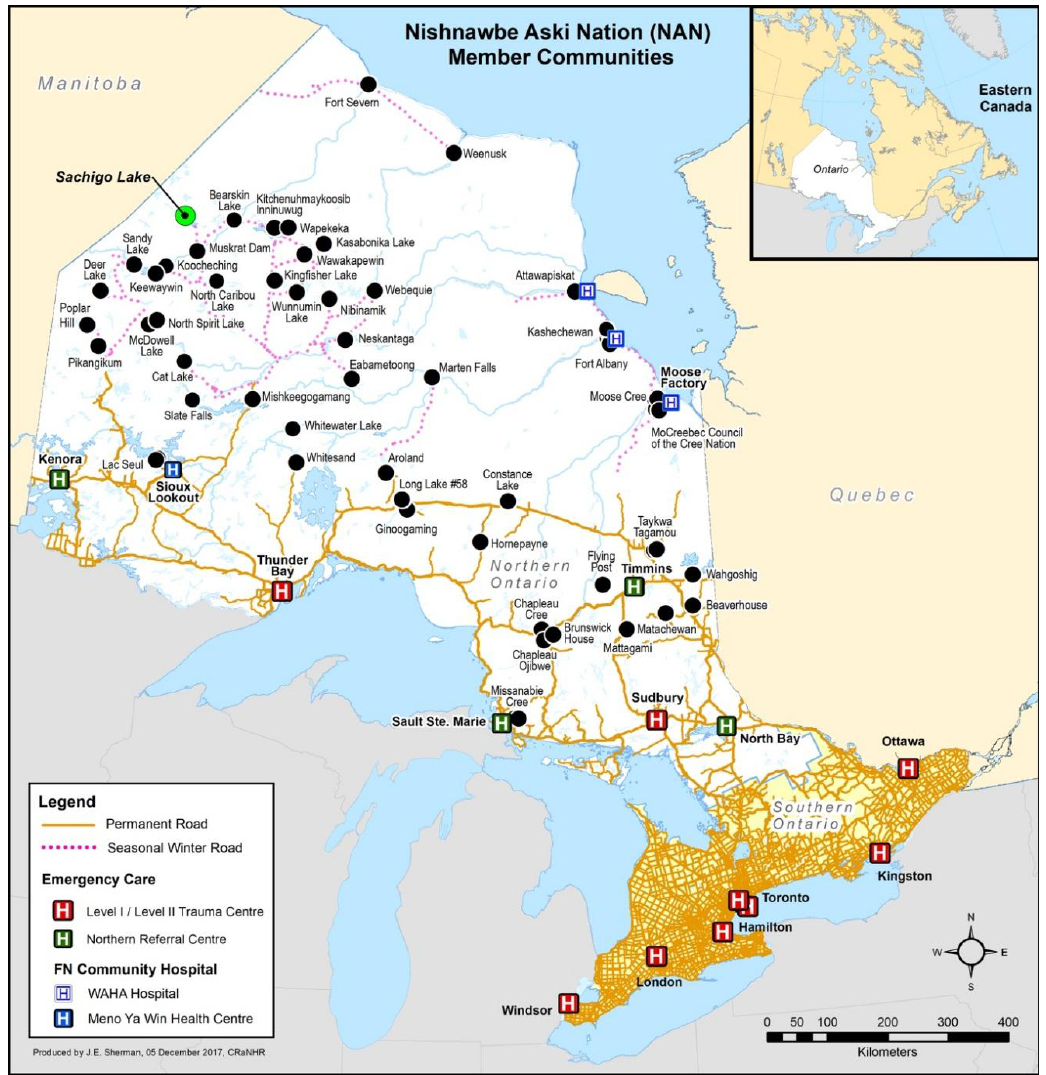
Figure 1. Map of Nishinawbe Aski Nation member communities, road access, community hospitals, and emergency care referral centers in northern Ontario.